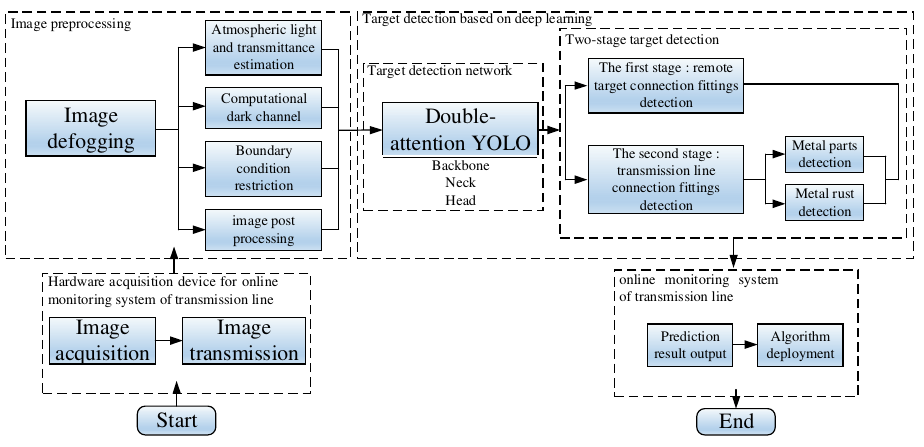
Figure 4. Overall deployment structure diagram of the algorithm.